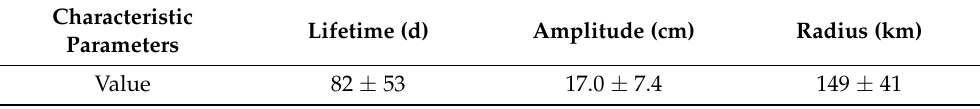
Table 2. Characteristics of the intrusion-of-continental-shelf mesoscale